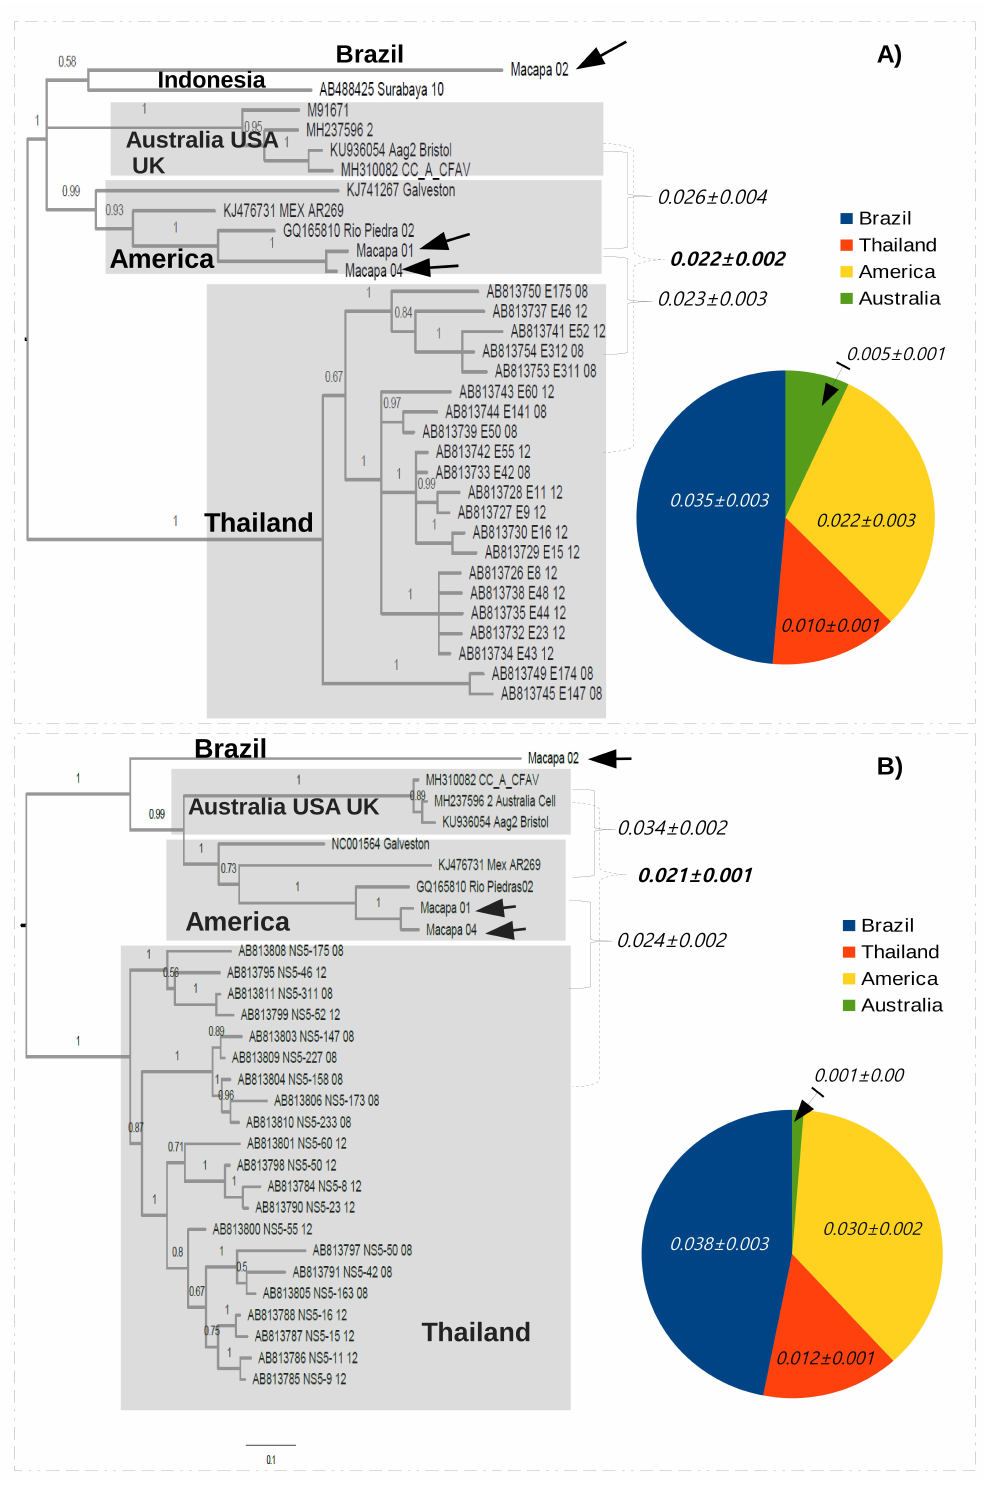
Figure 3. Bayesian trees reconstructed using the E and the NS5 genes ( A and B , respectively) of cell fusing agent virus (CFAV). The Brazilian strains described in the present study are indicated by arrows. Values on the trees indicate the statistical support (posterior probabilities) of each node. The topology shows three groups (gray areas) containing strains from certain geographical regions (i.e., Americas, Australia/USA/UK and Thailand). Braces indicate the genetic distances between phylogroups. The scale bar under the trees represents the nucleotide substitutions per site. The genetic distances were estimated within each group and are represented in the colored circles. Each colored sector represents a certain